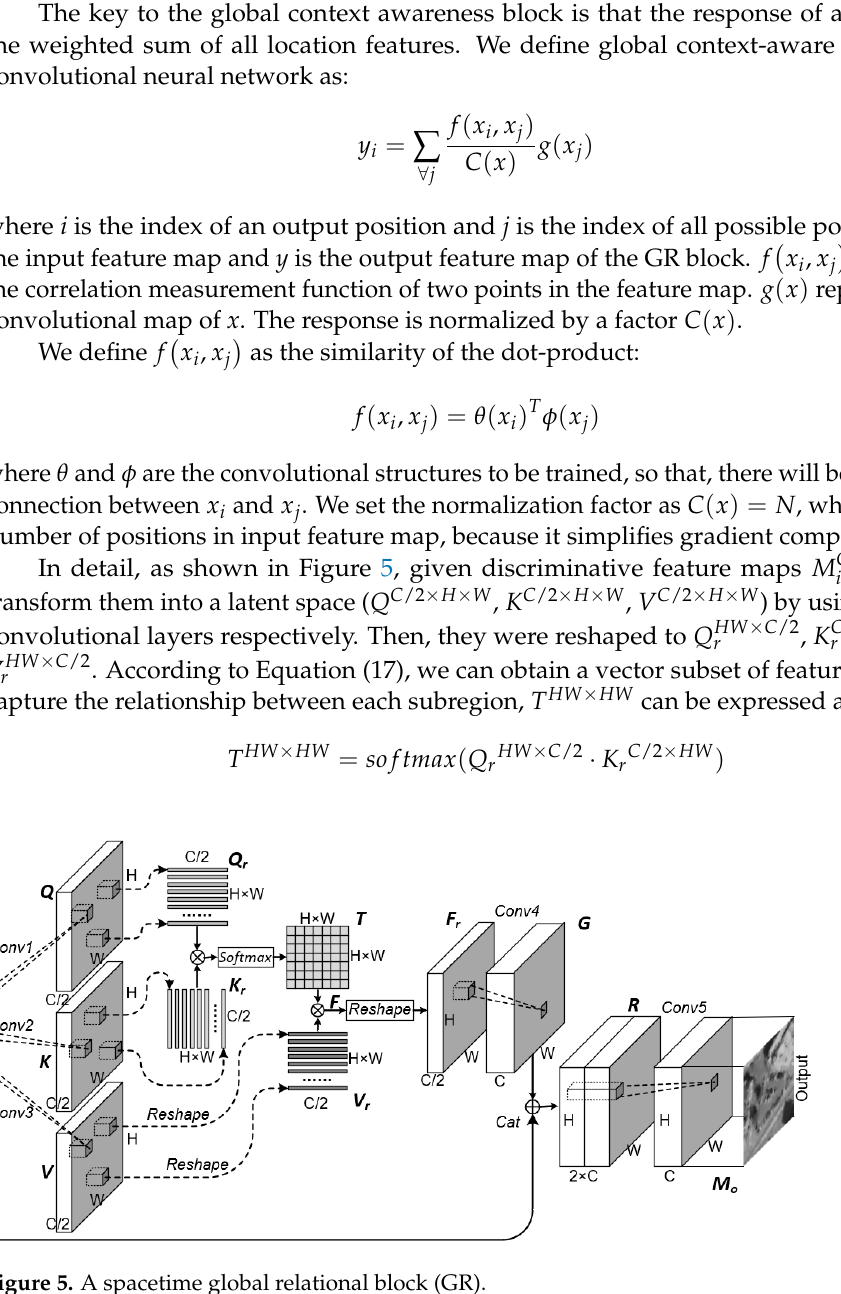
Figure 5. A spacetime global relational block (GR).